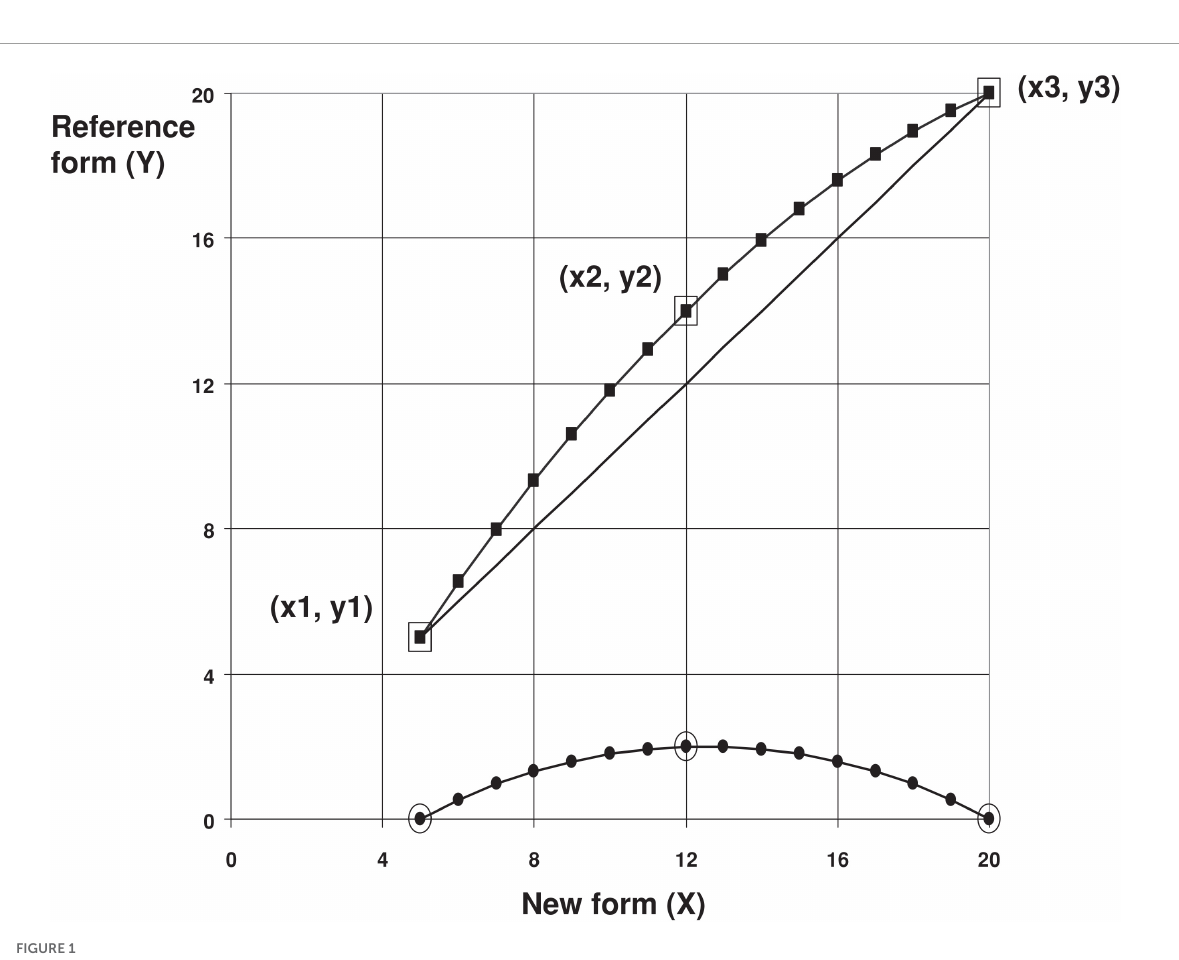
FIGURE1 Circle arc method of converted